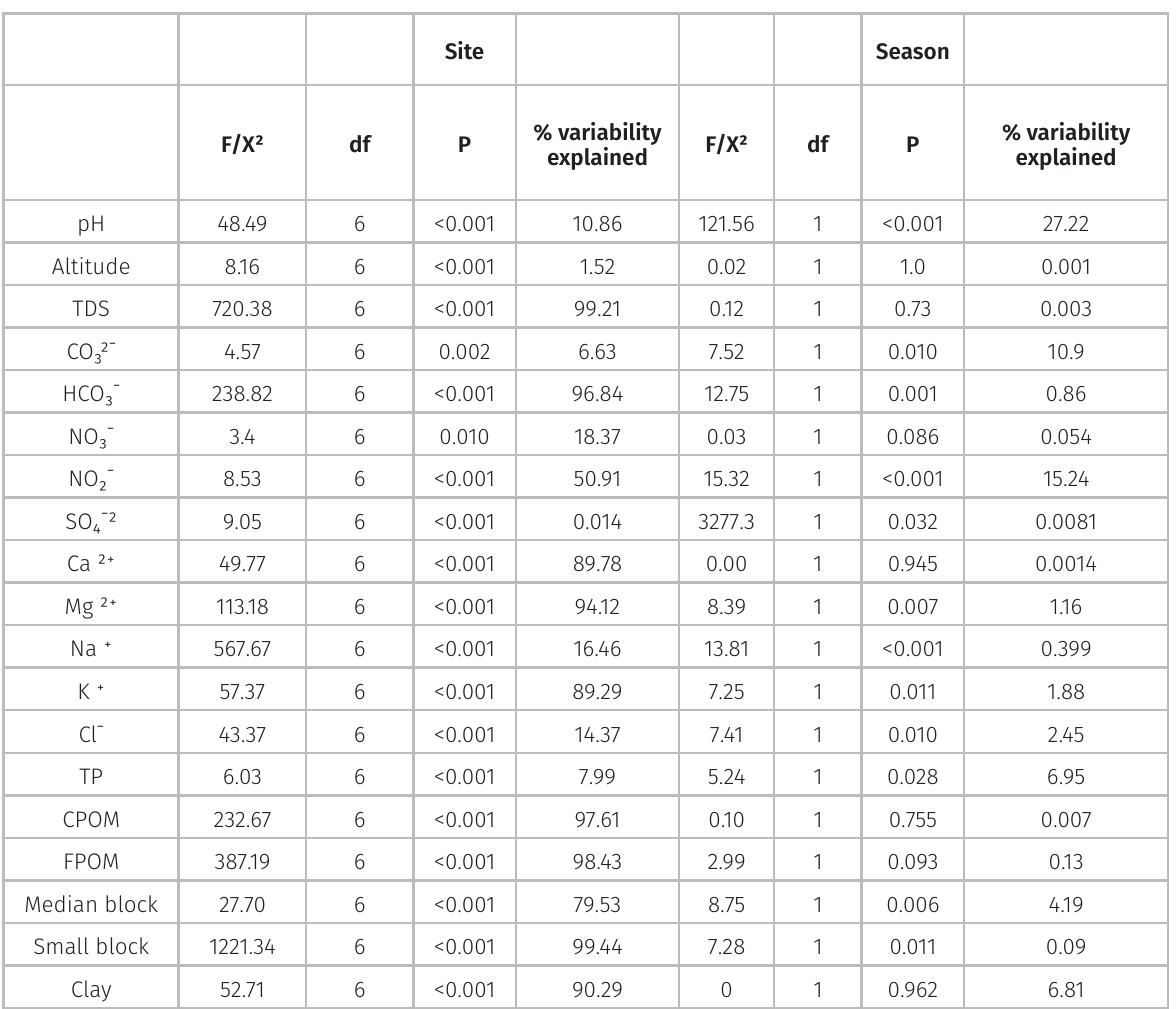
Table II. Summary of GLMs analysis used to examine differences in environmental variables among sites and